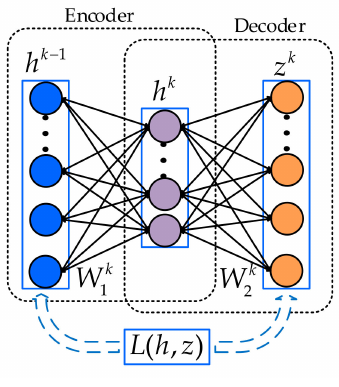
Figure 4. The k th